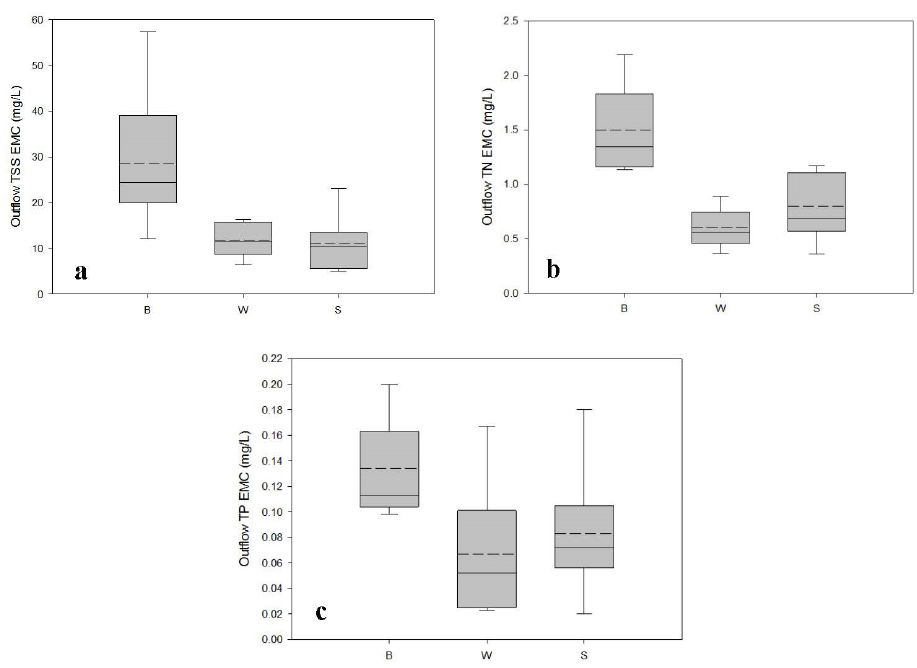
Figure 3. Outflow pollutant EMCs of WSUDs, ( a ) TSS; ( b ) TN; ( c ) TP. B = bioretention basin; W = constructed wetland; S = roadside swale.